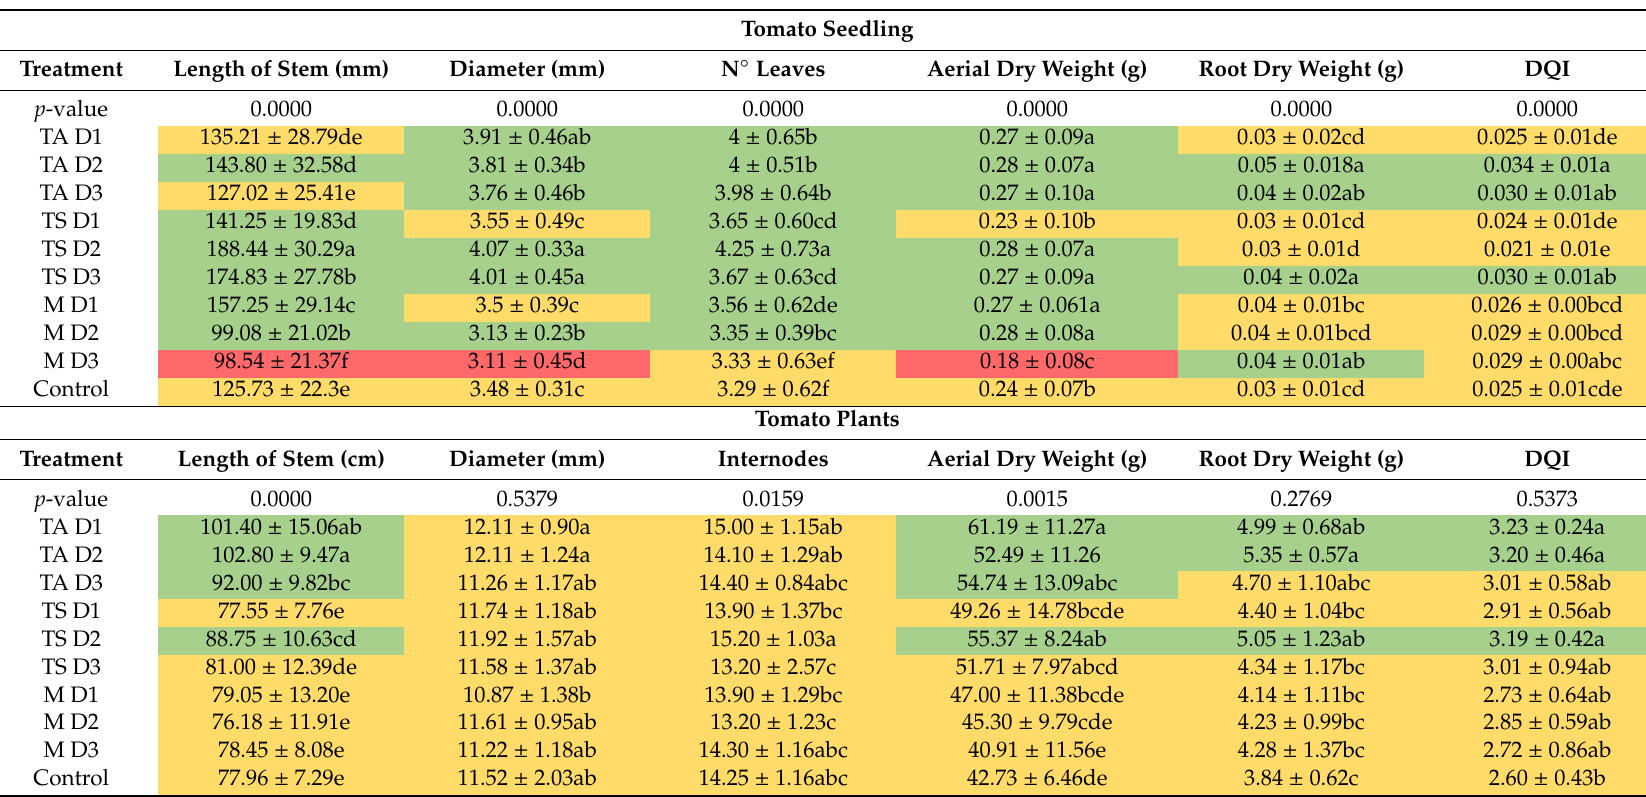
Table 5. Morphological parameters and DQI of tomato seedlings and plants treated with di ff erent doses (10 5 , 10 6 and 10 7 spores per plant; D1, D2 and D3, respectively) of T. aggressivum f. europaeum (TA), T. saturnisporum (TS) and mix (M) of two